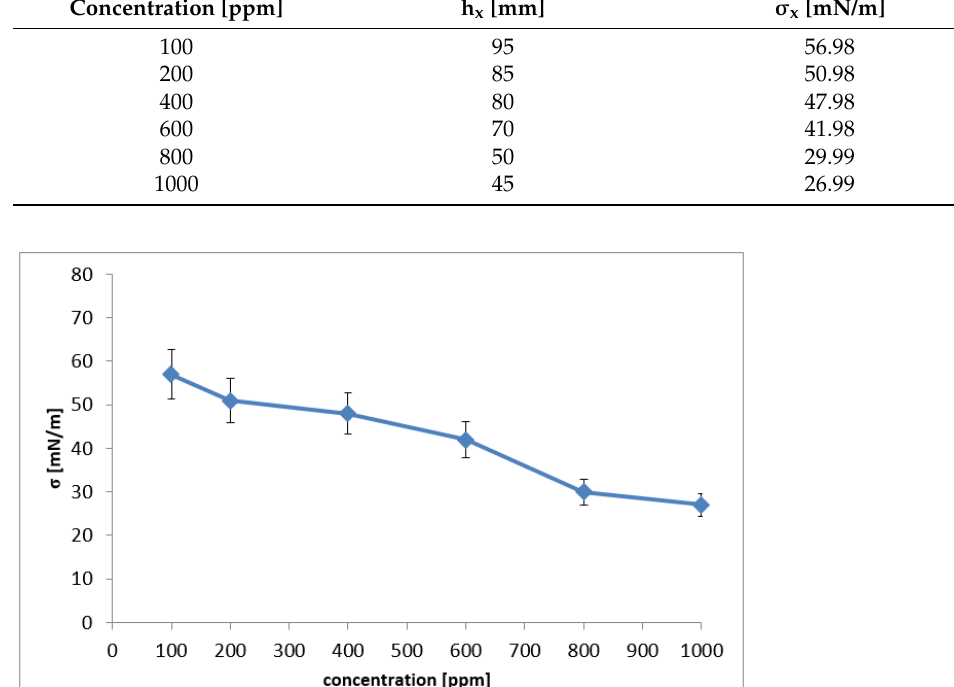
Table 6. Results of surface tension of extracts at different mixing times